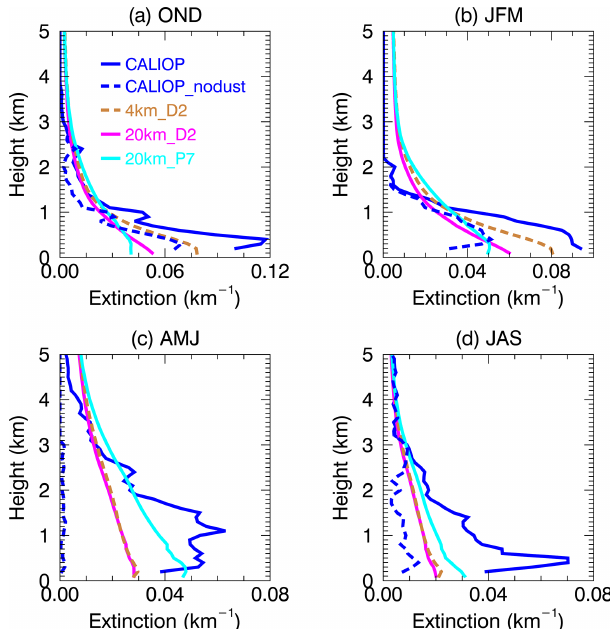
Figure 15. Vertical distribution of seasonal mean 532nm aerosol extinction coefficient (km − 1 ) from CALIOP, CALIOP_nodust and the WRF-Chem (4km_D2, 20km_D2 and 20km_P7) simulations over the red box region in Fig. 1a in